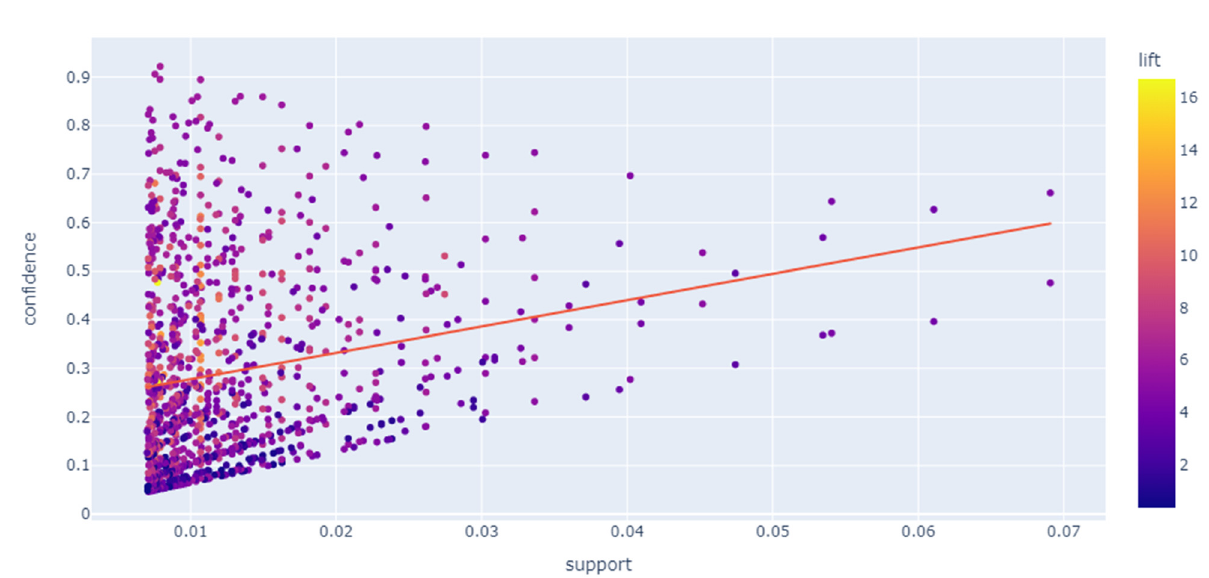
Figure 10. Generated association rules metrics correlation.